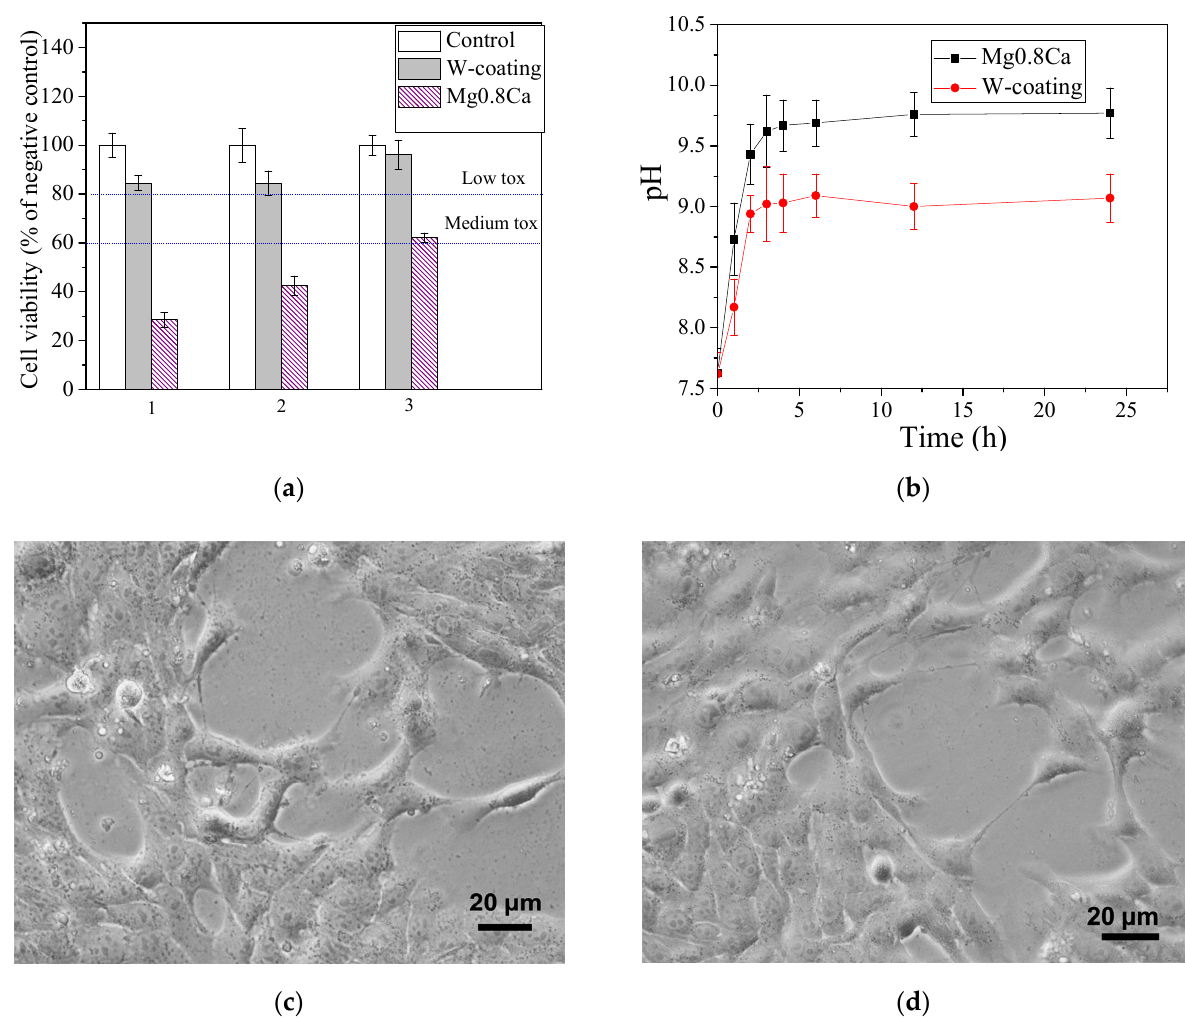
Figure 15. ( a ) — Results of the in vitro cytotoxic test of the Mg.08Ca and W-coating extracts measured by an MTT assay (1); when the extracts were diluted 10 (2) and 100 (3) times. ( b )—Kinetics of pH changes in the cell medium during interaction with the samples. ( c , d )—3T3 cells after incubation with the control and with the coating, respectively.